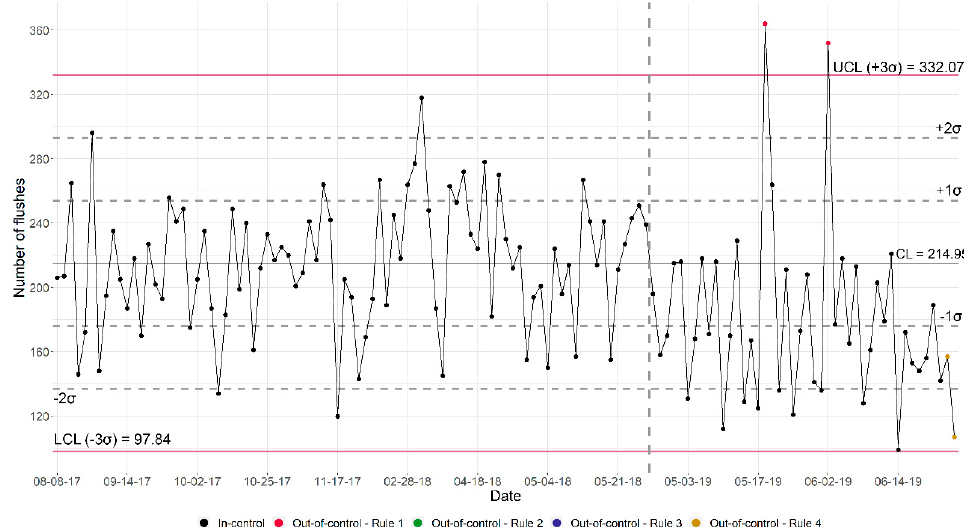
Figure 3. Shewhart Control Chart—Total number of flushes per day.